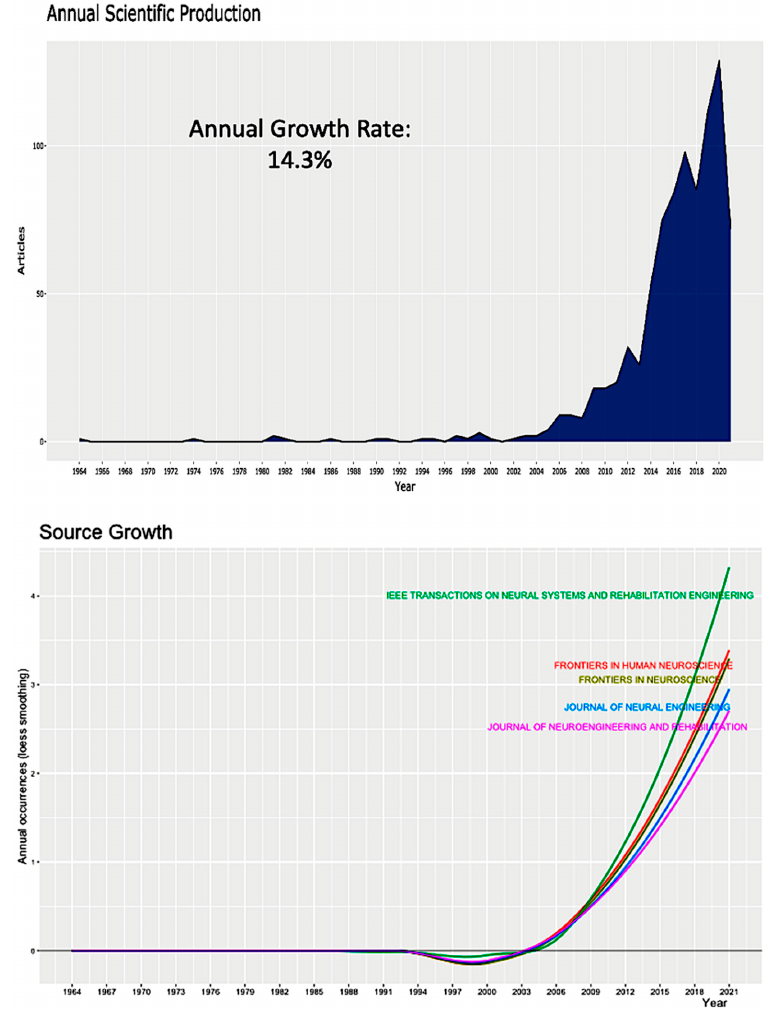
Figure 1. According to the annual scientific production (top) and source growth (bottom), there is rising scientific interest in using EEG in neurorehabilitation. rising scientific interest in using EEG in